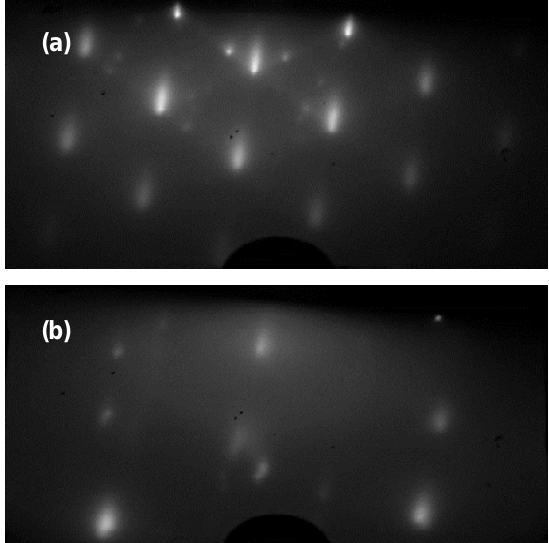
Fig. 7. RHEED patterns of the SiC layer grown on single-crystal Si (100) surface; projected onto the axis [001] (a) and projected onto the axis [011]